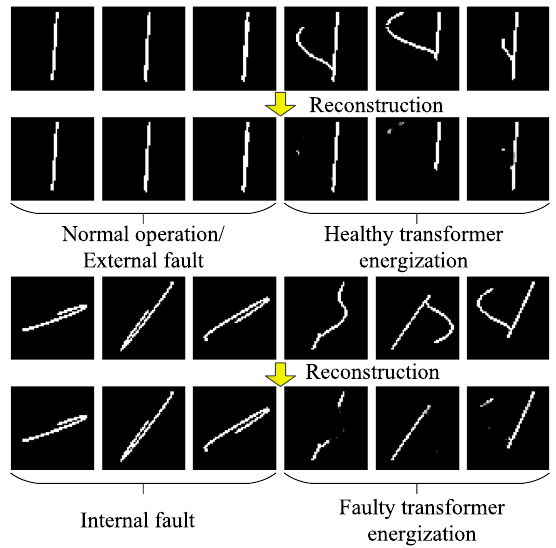
Fig. 9 Reconstruction results of validation samples